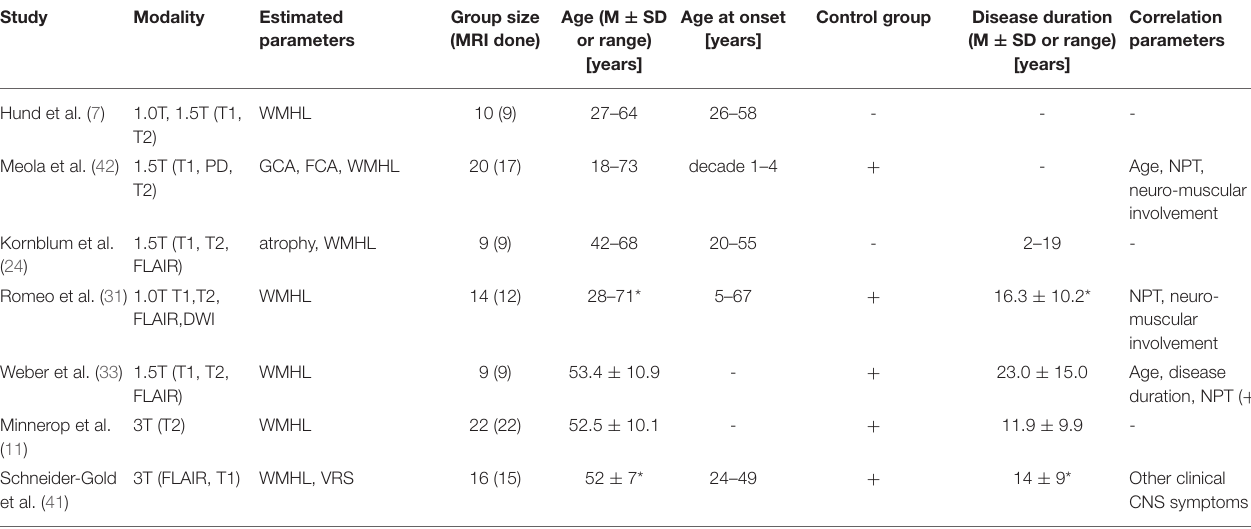
TABLE 5 | Conventional MRI in DM2.